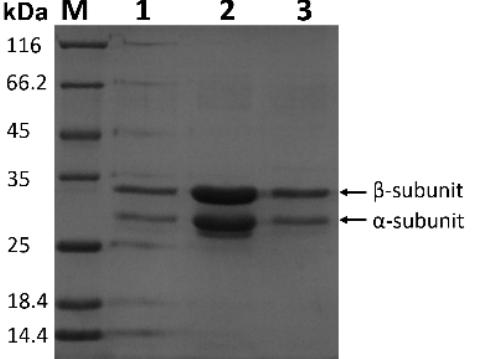
Figure 2. SDS-PAGE analysis of purified protein. Lane M: protein molecular weight marker; Lane 1: protein fraction eluted by 50 mM imidazole; Lane 2: protein fraction eluted by 75 mM imidazole; Lane 3: protein fraction eluted by 100 mM